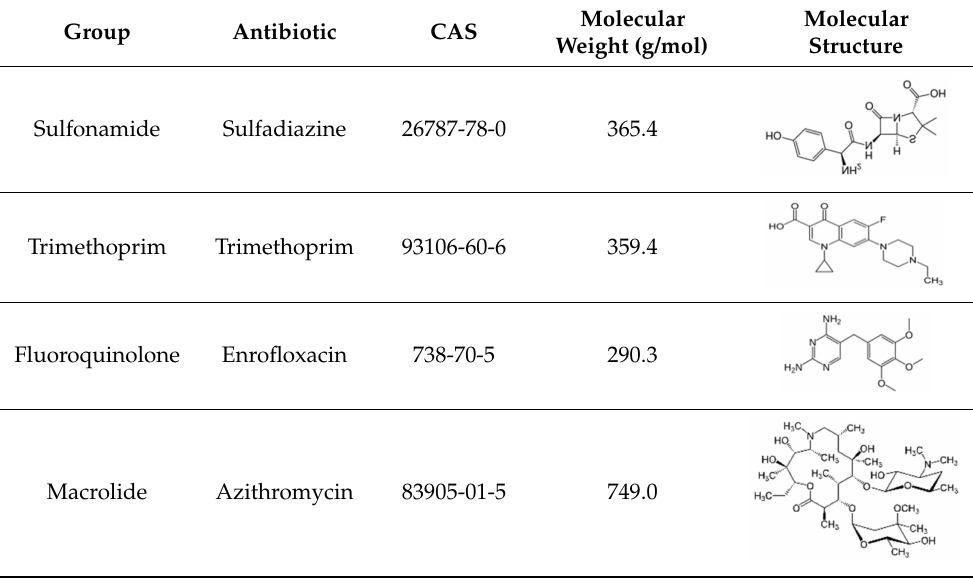
Figure 4. Frequency of occurrence of most detected antibiotics in the screening (2018). Table 3. Antibiotics